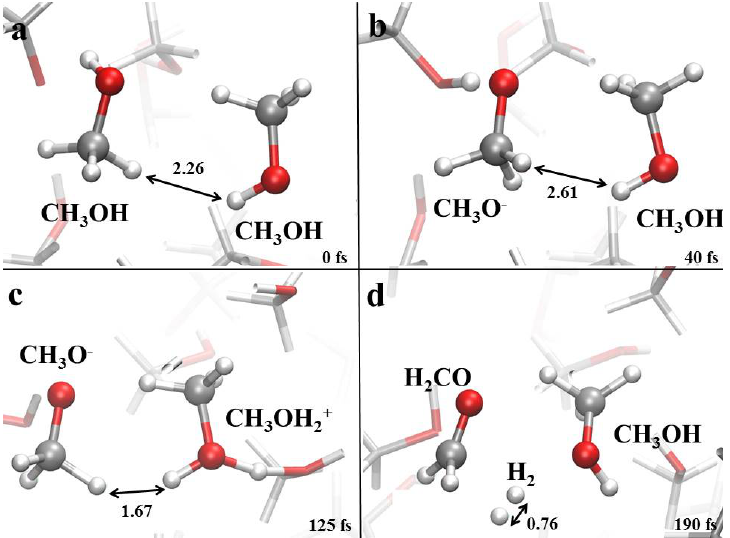
Figure 5. ( a – d ) Formaldehyde and molecular hydrogen formation mechanism in neat methanol and in a 75:25 methanol-water mixture under the action of a static electric field having intensity equal to 0.40 V/Å and 0.50 V/Å, respectively. White, red, and silver coloring refer to hydrogen, oxygen, and carbon atoms, respectively. A hydrogen-hydrogen distance, shown in Å, is highlighted to better follow the evolution of the